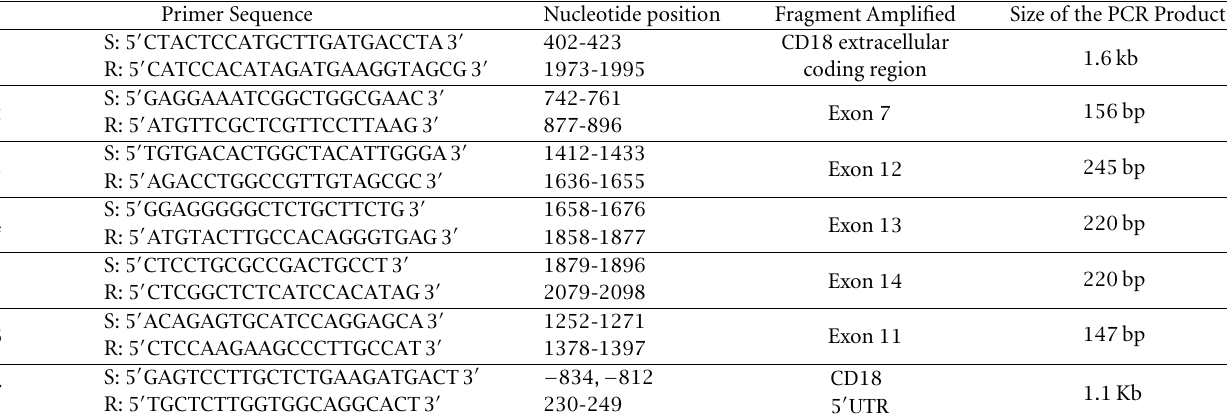
Table 1: PCR primers used to generate ITGB 2 cDNA or genomic specific DNA fragments. Nucleotide numbering is according to position + 1 being the first nucleotide of the initiation codon ATG in the normal CD18 cDNA sequence. 5 (cid:2) UTR = 5 (cid:2) untranslated